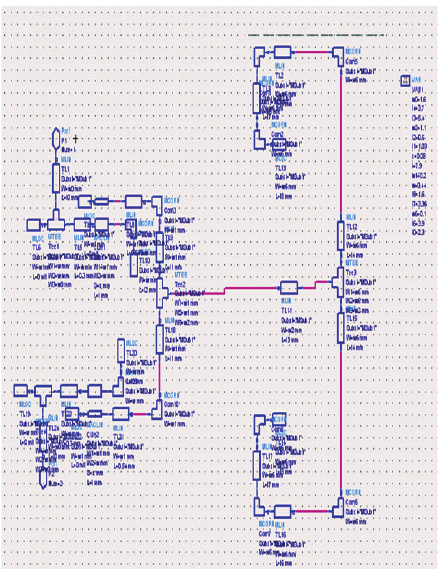
Figure 7: Implemented structure of the filter of Figure 6 in the S -parameters workspace of the ADS